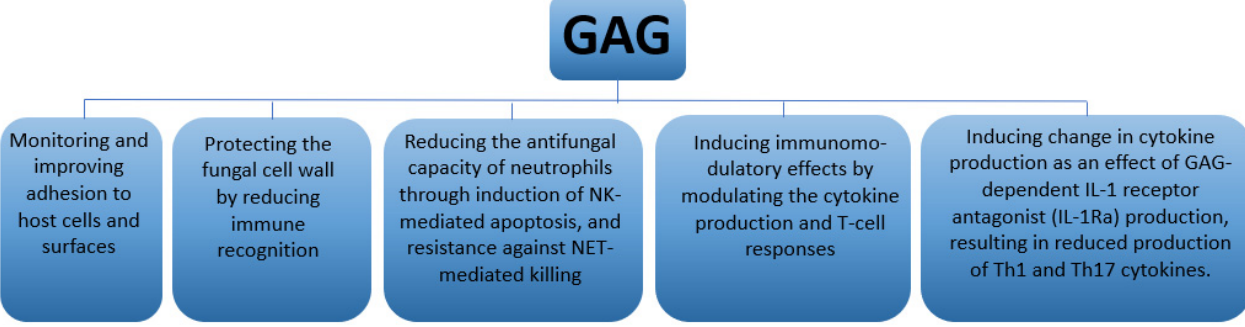
Figure 1. Potential roles of GAG during fungal infection.